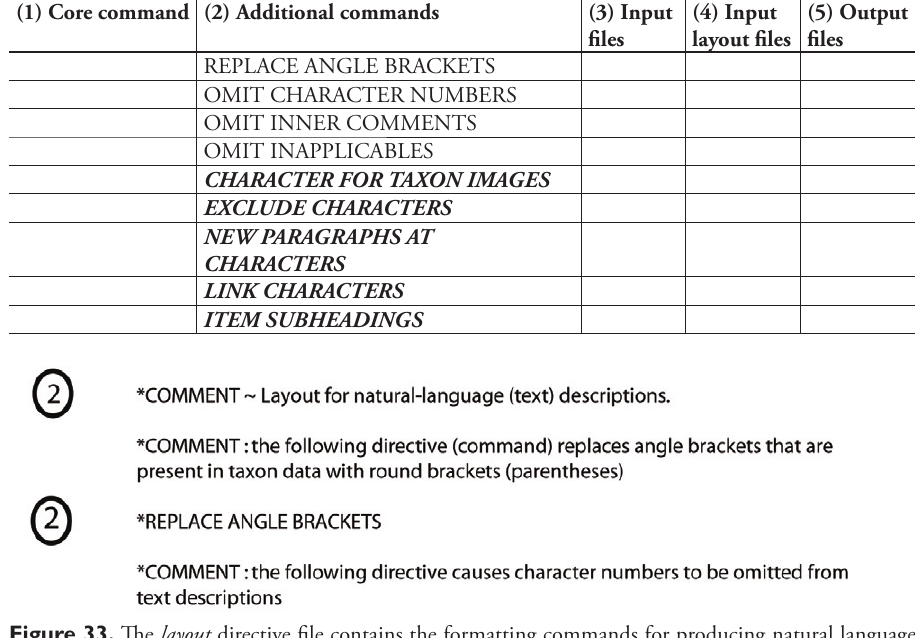
Table 6. Classifi cation of commands used in the layout directive fi le. Reference numbers used in Fig. 33 are given in the header of the table. Th e commands in bold and italics may require changes being made by the